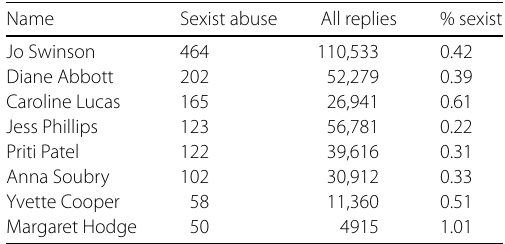
Table 6 Individuals receiving more than 0.2% sexist abuse and at least 50 sexist items in